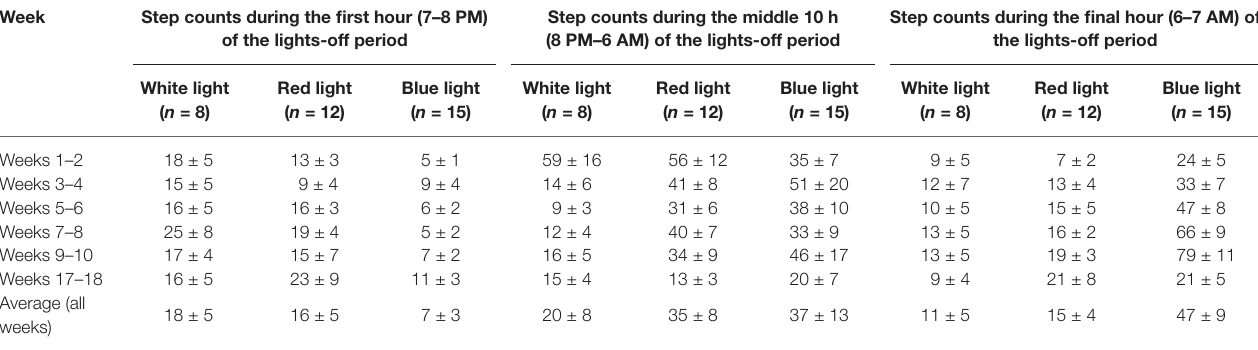
TABLE 3 | Average activity (step counts) during the first hour (7–8 PM), middle 10 h (8 PM–6 AM), and final hour (6–7 AM) of the lights-off period for white, red, and blue light reared monkeys by 2-week